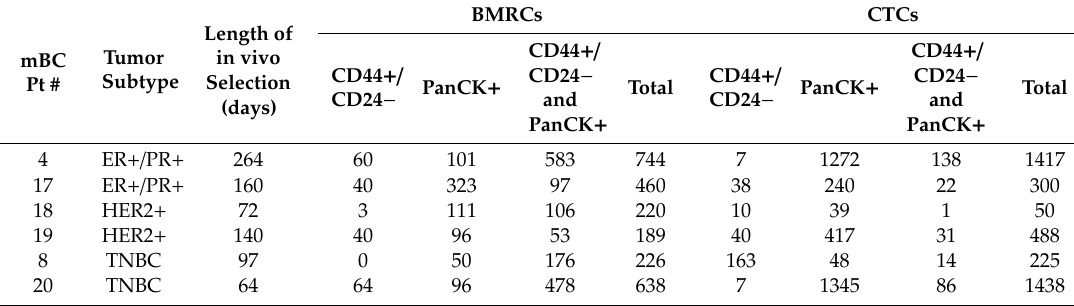
Table 1. Number and biomarker definition of ex vivo BMRCs and CTCs.